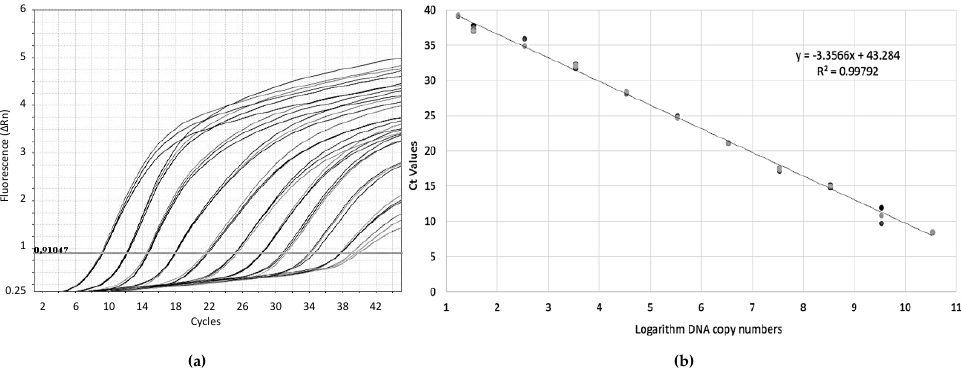
Figure 2. ( a ) Amplification plots by GRLDaV real-time qPCR for three replicates of serial dilutions of plasmid DNA containing the GRLDaV target region. ( b ) Quantitation standard curve generated. Both the mathematical equation of the curve and the coefficient of correlation (R 2 ) are indicated.